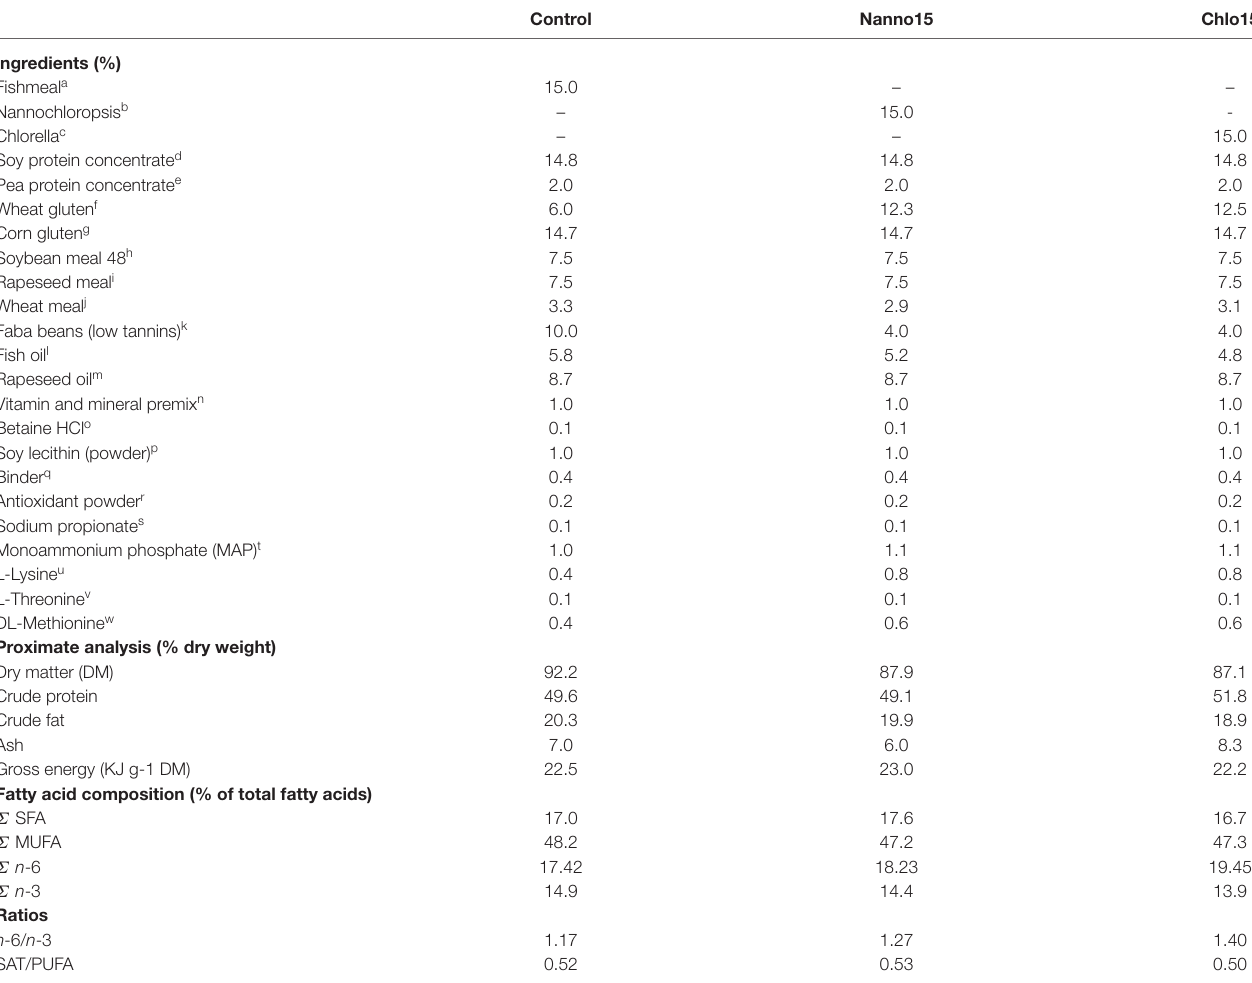
Control Nanno15 Chlo15